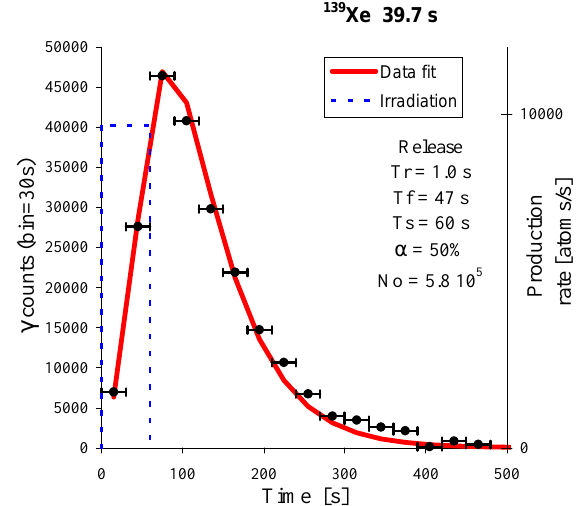
FIG. 1. (Color) Time distribution for release and transport of 139 Xe observed at cold finger. The solid line corresponds to a fit (see text).